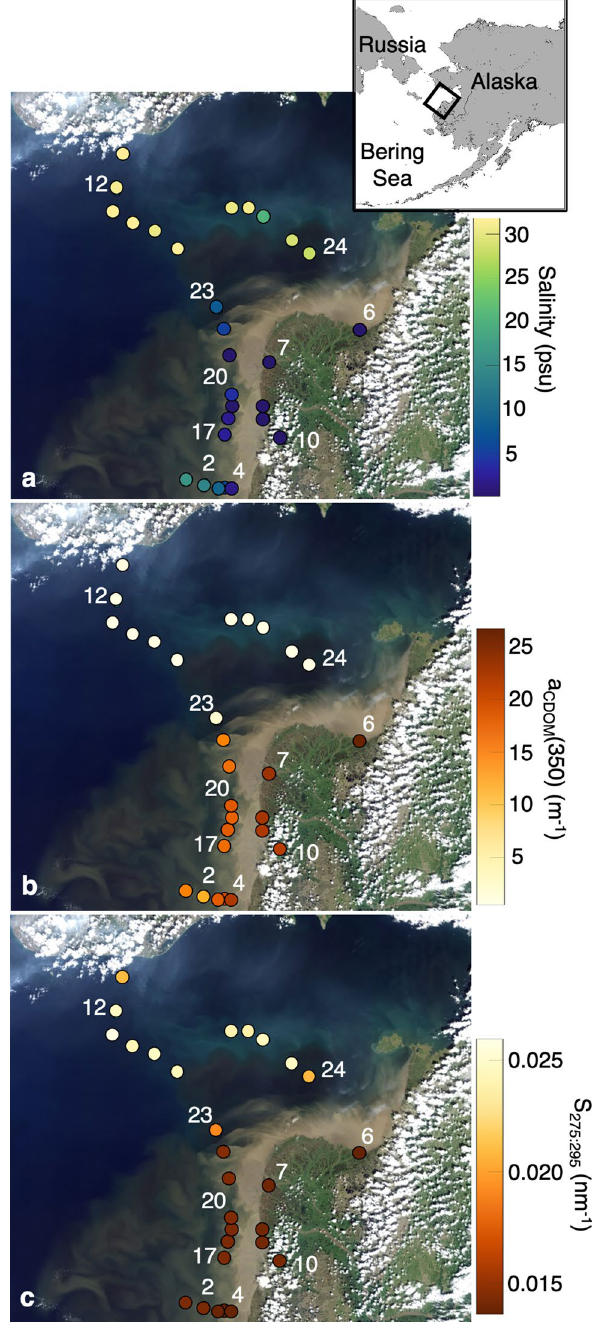
Figure 5. Landsat 8 OLI merged scenes from June 16 and June 18, 2019 of the Yukon River delta and Norton Sound, overlaid with ( a ) salinity, ( b ) a CDOM (350) and ( c ) S 275:295 for all stations sampled (n = 28). Incubation station locations are noted by number. Figure inlay indicates regional location of the Landsat 8